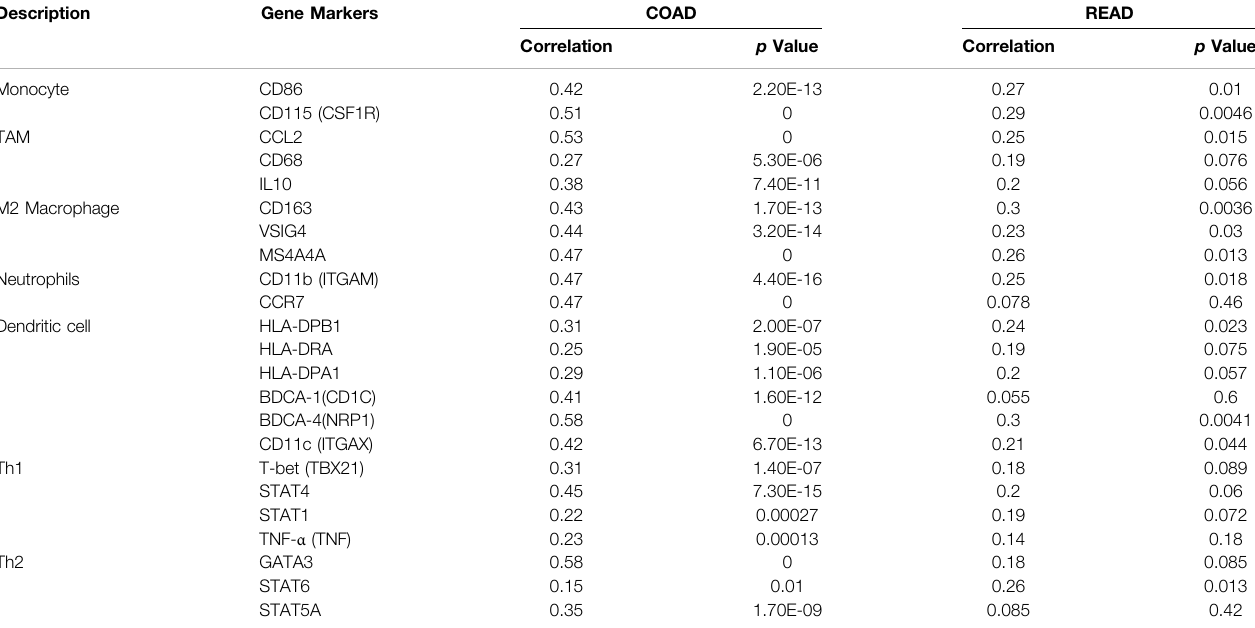
TABLE 2 | Correlation analysis between RIMKLB and signi fi cant gene markers of immune cells in GEPIA. Description Gene Markers COAD